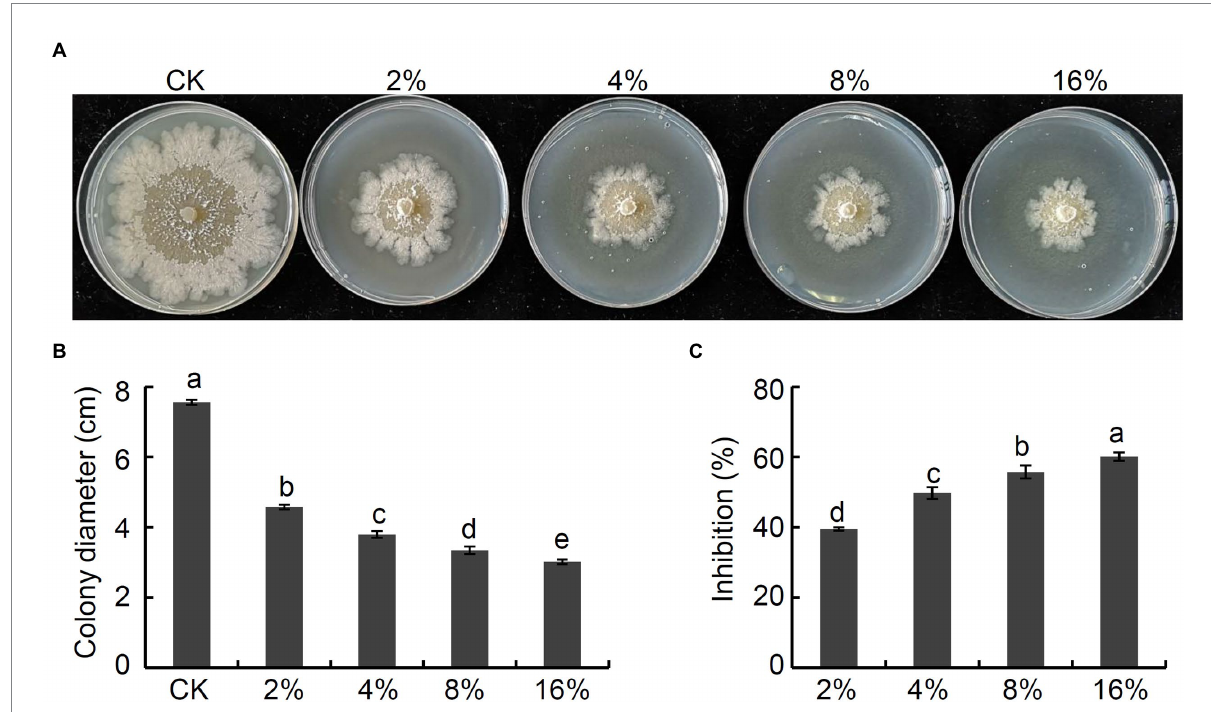
FIGURE 2 Antifungal activity of culture filtrate of strain Nl4 against V. pyri . (A) Effect of culture filtrate of strain Nl4 on mycelial growth of V. pyri . The picture was taken at 6 dpi. (B) Statistical analysis of colony diameter. (C) Inhibition of strain Nl4 culture filtrate on mycelial growth of V. pyri . Each data represents the mean ± SD of three replicates. Letters above the bars indicate statistical significance and different lowercase letters indicate significant different means ( p < 0.05) based on Student’s